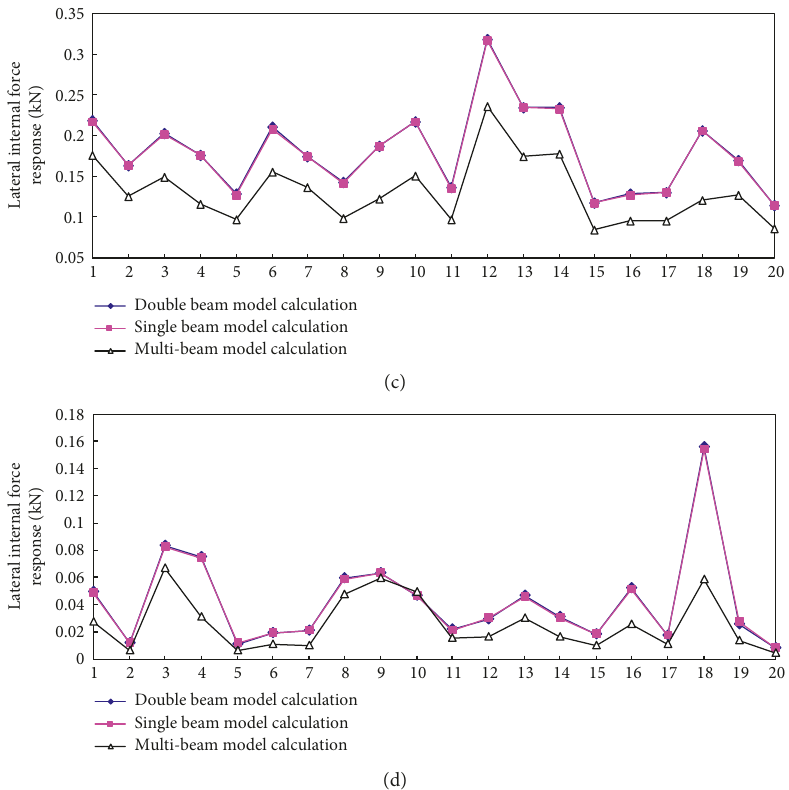
Figure 9: Lateral internal force response of the support. (a) No. 1 support. (b) No. 2 support. (c) No. 3 support. (d) No. 4 support.